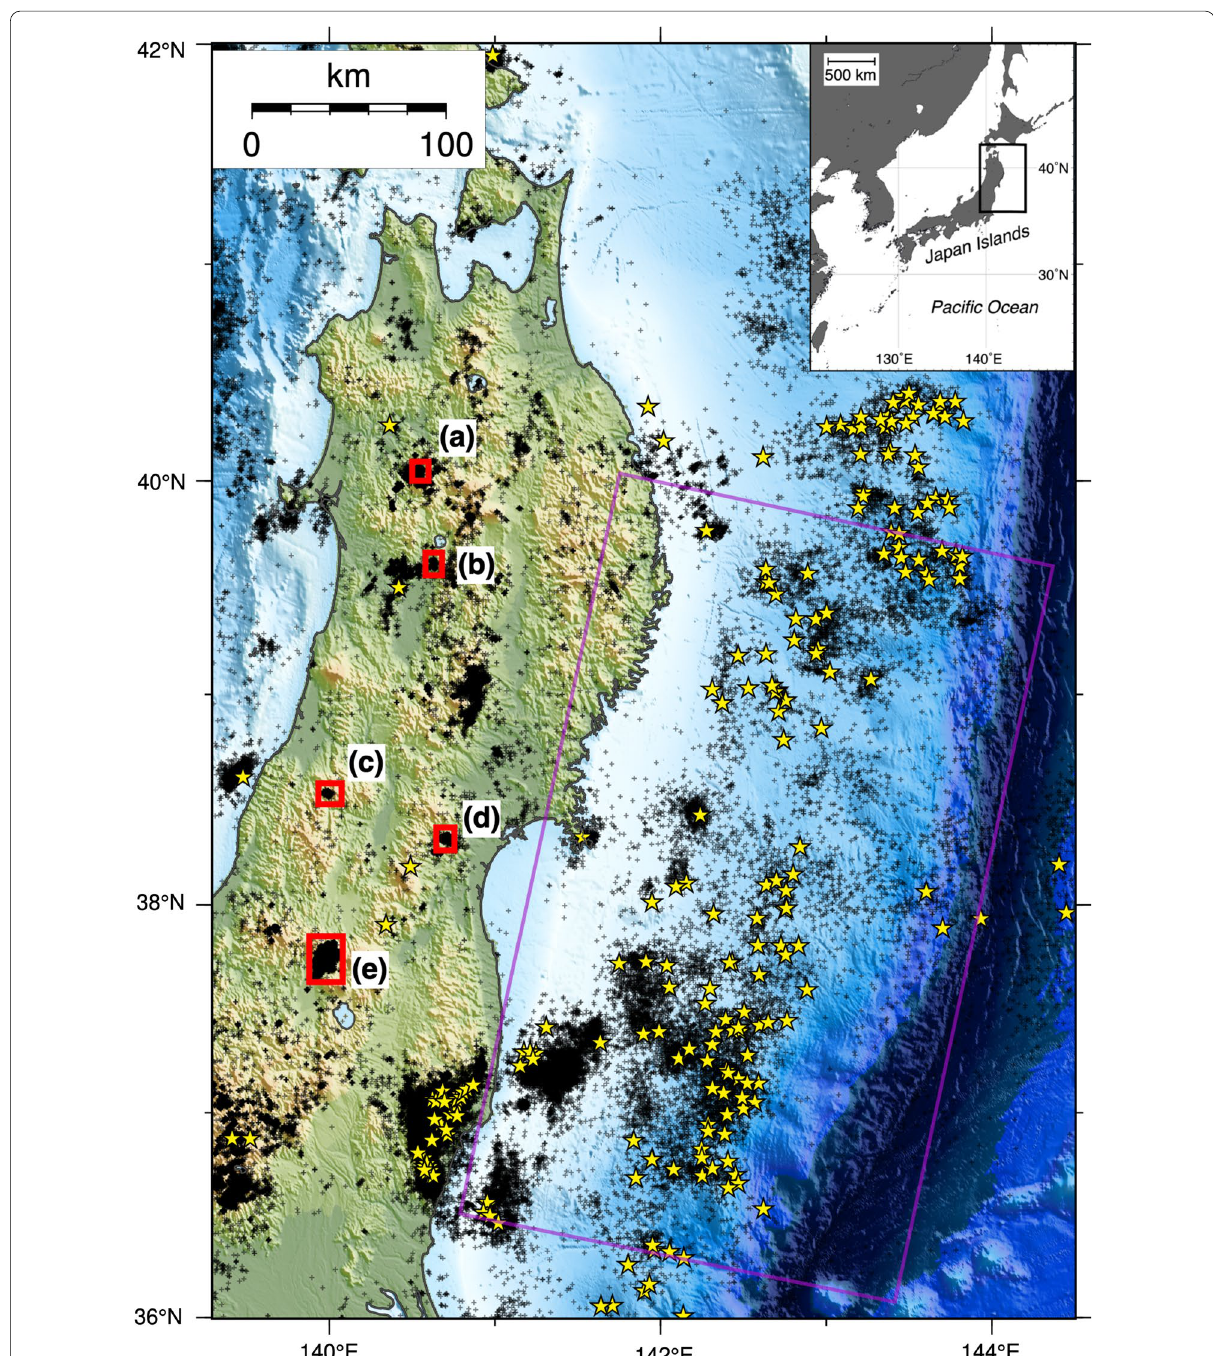
Fig. 1 Seismicity of northeastern Japan after the 2011 Off the Pacific Coast of Tohoku earthquake. Black crosses and yellow stars denote epicenters of M 1.0 and M 5.0 earthquakes, respectively, in the period from 11 March 2011 to 31 December 2019 at depths shallower than 20 km. ≥ ≥ Hypocenter data are taken from the unified catalog of the Japan Meteorological Agency. Red rectangles indicate the areas analyzed in this study: (a) Moriyoshi, (b) Kakunodate, (c) Gassan, (d) Sendai, and (e) Yonezawa–Kitakata. The purple rectangle shows the area of the fault model for the Tohoku earthquake (Yamazaki et al.